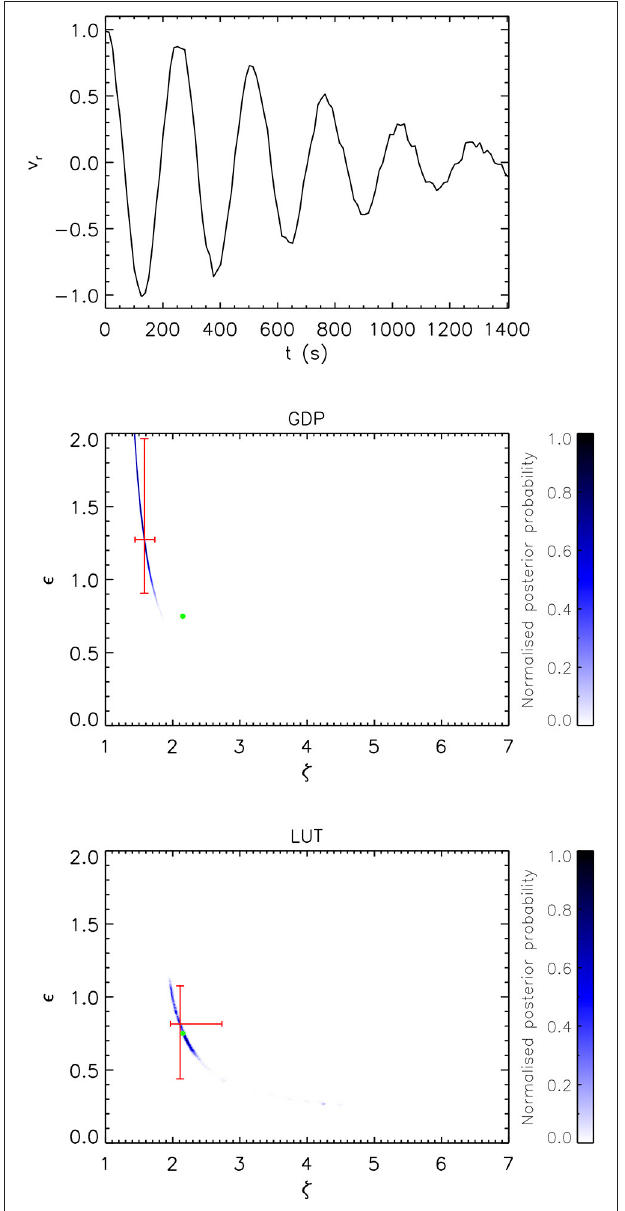
FIGURE 9 | Seismological test as in Figure 8 for ζ = 3.75 and ǫ =